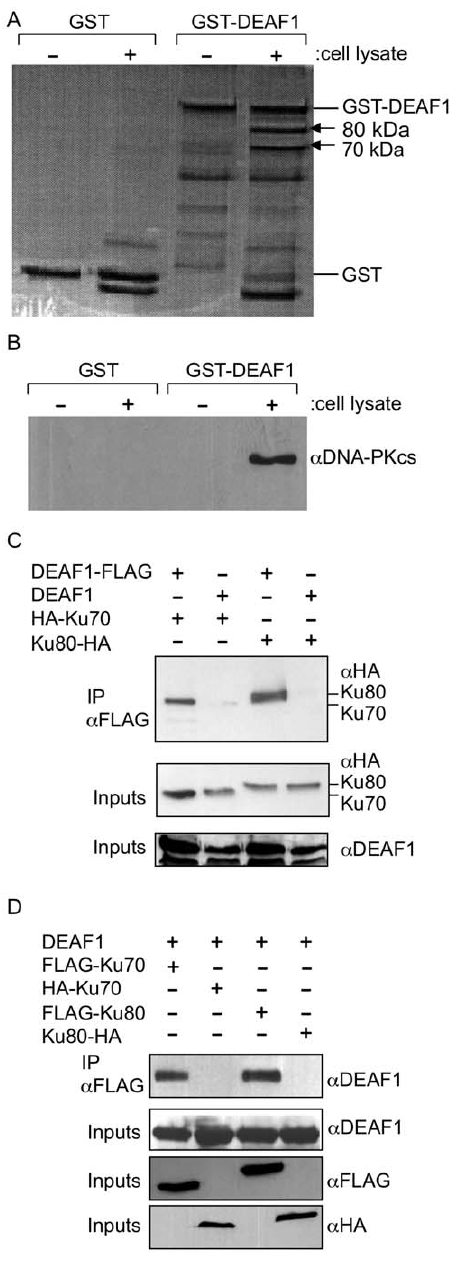
Figure 1. DEAF1 interacts with the DNA-PK complex. Recombi- nant GST and GST-DEAF1 fusion proteins were isolated from bacterial extracts, bound to glutathione-Sepharose beads, and incubated overnight in the presence ( + ) or absence ( 2 , buffer only) of PC-3 cell lysates. Interacting proteins were eluted, separated by SDS-PAGE, and stained with Coomassie blue ( A ) or analyzed by Western blot with an antibody to DNA-PKcs ( B ). The 70 kDa and 80 kDa proteins (arrows) were determined by mass spectrometry to be Ku70 and Ku80. ( C ) CV1 cells were transfected with expression plasmids for DEAF1-FLAG and/or HA-tagged Ku proteins. Cell lysates were immunoprecipitated (IP) with anti-FLAG coupled beads followed by Western blot analysis with anti- HA antibody. ( D ) Reversing the epitopes described in (C), lysates of cells transfected with DEAF1 and FLAG-tagged or HA-tagged Ku proteins were immunoprecipitated with anti-FLAG coupled beads followed by Western blot analysis with anti-DEAF1 antibody. Levels of the proteins in 1.0% of the cell lysates (inputs) used in the immunoprecipitation reactions in C and D were assessed using the antibodies indicated. The results are representative of two independent experiments.